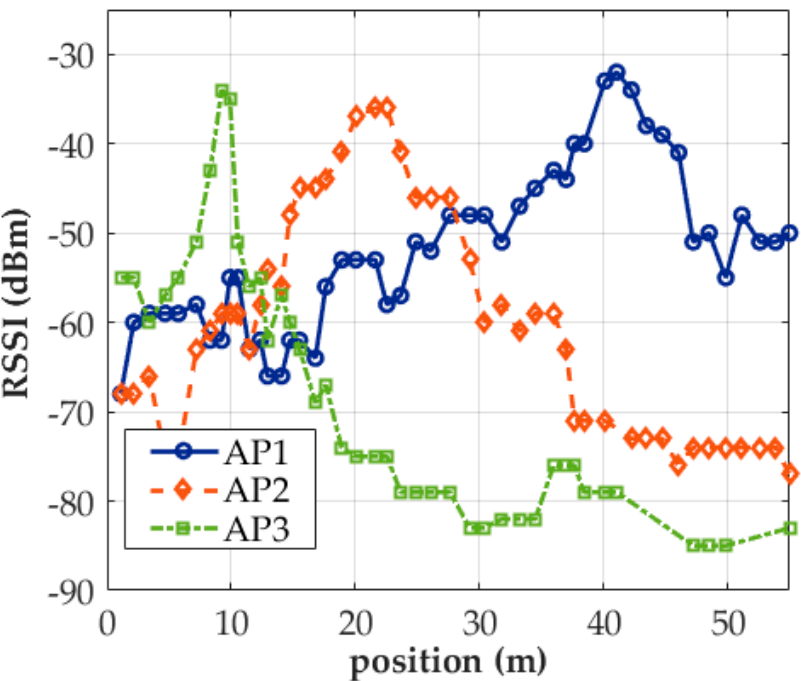
Figure 6. Distributions of AP signals collected at the 2.4-GHz band through MS (markers on the curves indicate where valid data were collected).